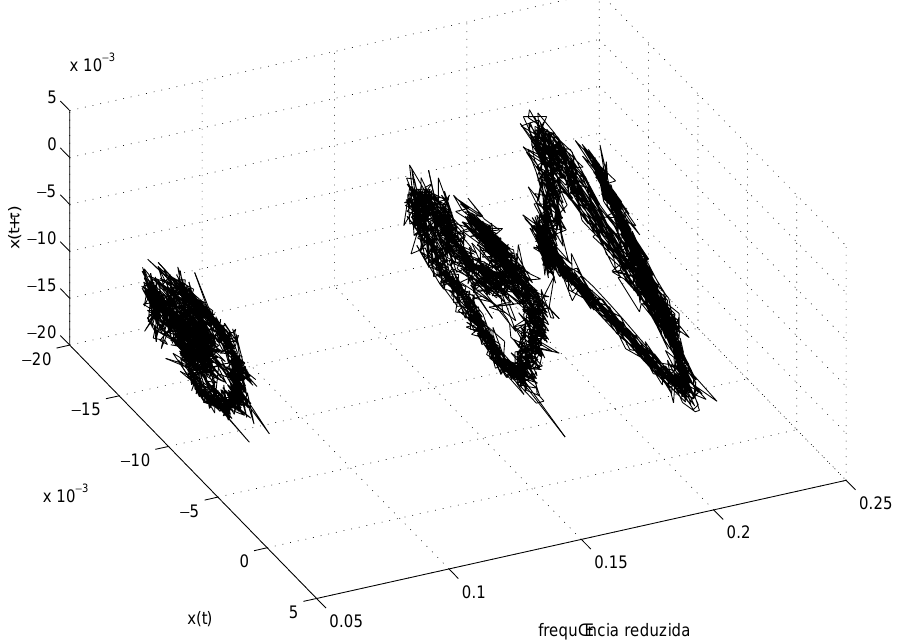
Fig. 8. Reconstructed state spaces for torsional measurements with reduced frequency variation (cases 3 to 5 from Table